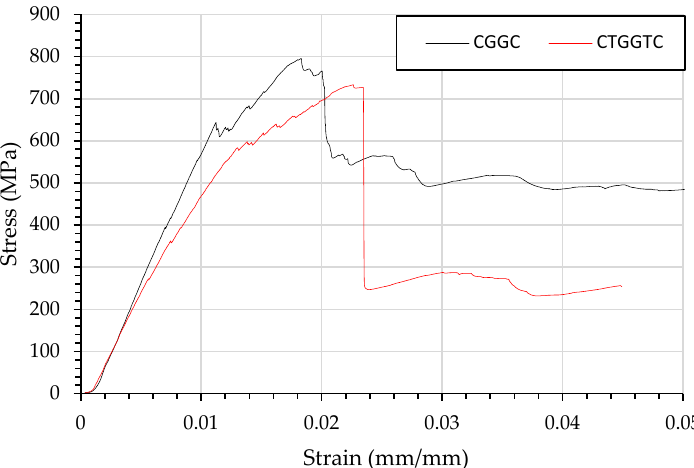
Figure 8. Flexural testing using three-point bending of composites beams and resulting stress strain curve of CGGC and CTGGTC.